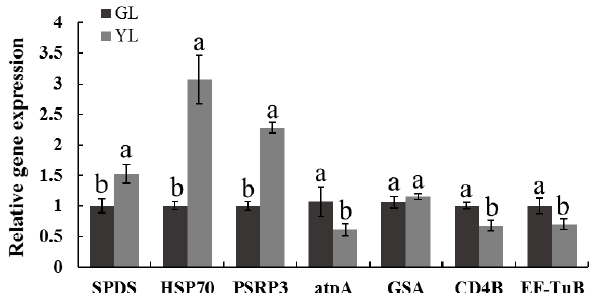
Figure 5. Expression levels of selected protein-encoding genes in G. biloba . SPDS, HSP70, PSRP3, atpA, GSA, CD4B and EF-Tu are spermidine synthase (spot 5032), heat shock 70 kDa protein (spot 5033), plastid-specific 30S ribosomal protein 3(spot 0038), ATP synthase CF1 α chain (spot 2134), glutamate-1-semialdehyde aminotransferase (spot 2239), ATP-dependent Clp protease ATP-binding subunit clpA homolog CD4B (spot 3940), and elongation factor TuB (spot 2135), respectively. Different letters indicate significant differences at p < 0.05.